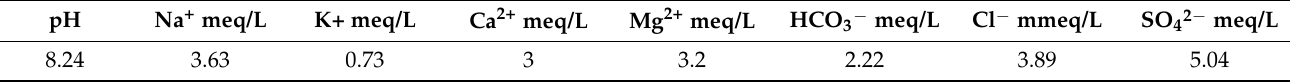
Table 2. Routine analysis of general empirical